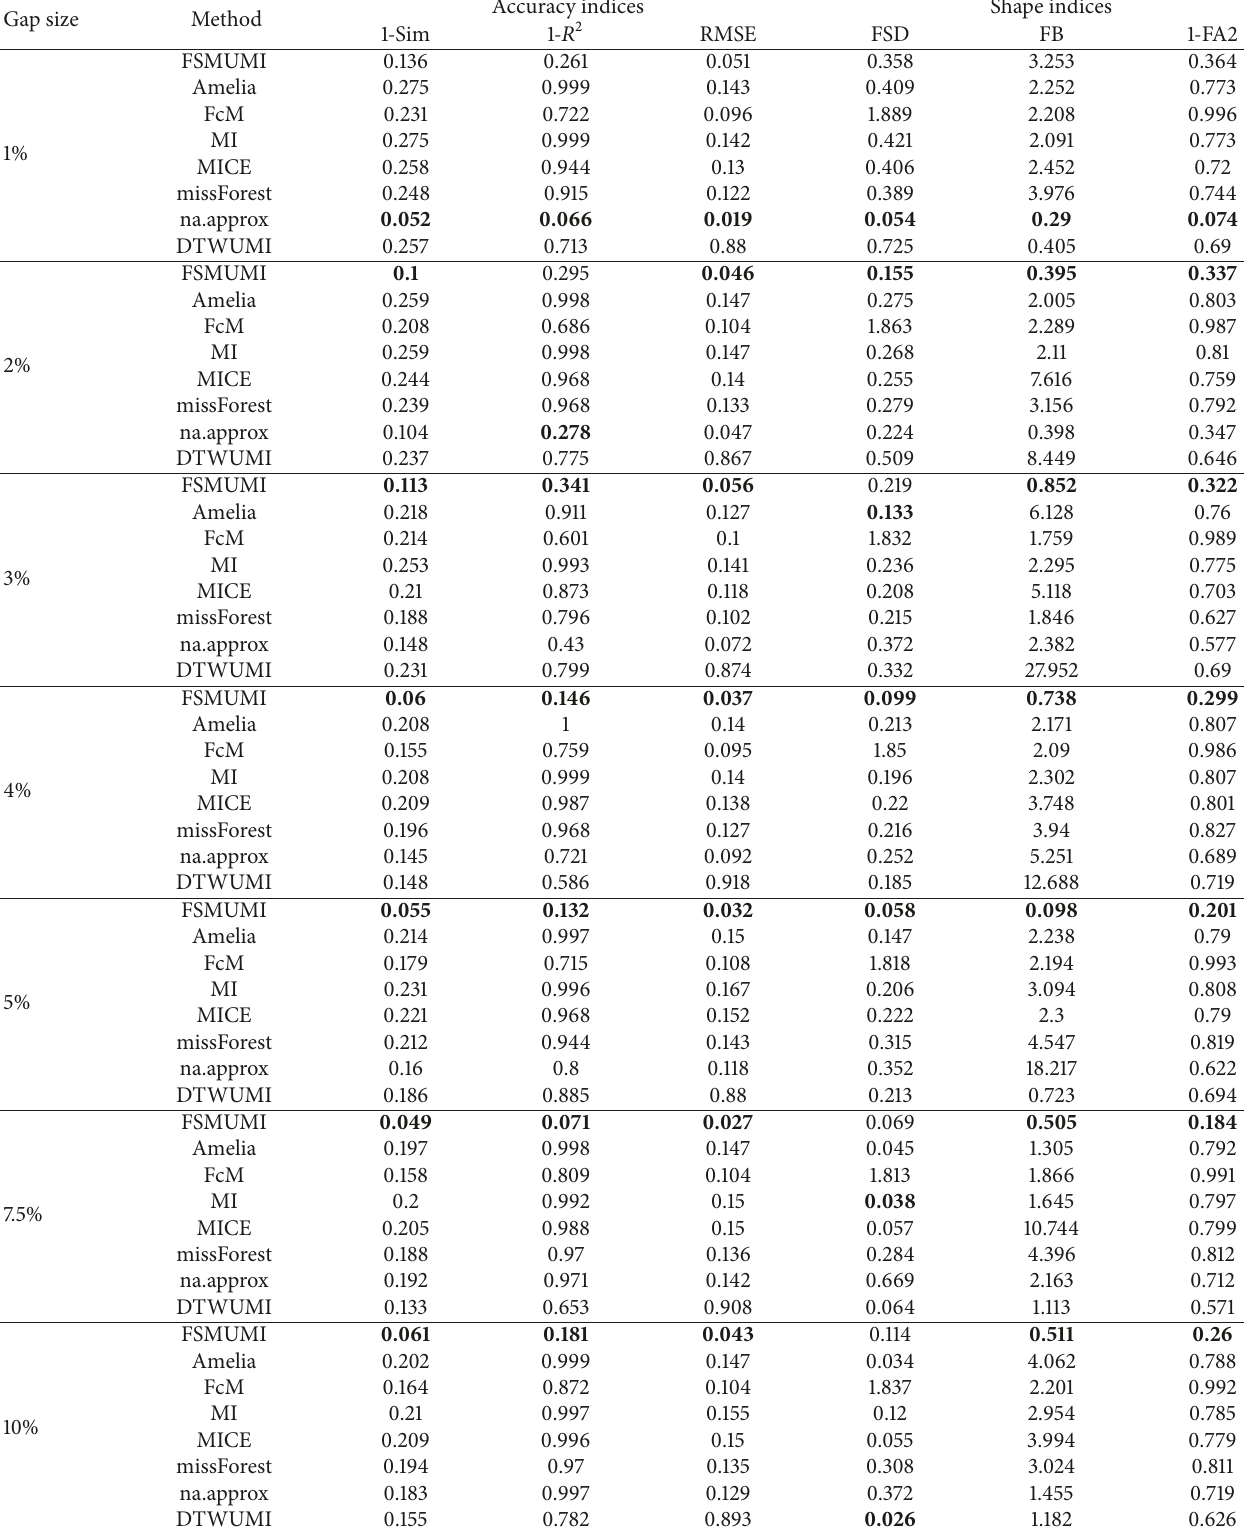
Table 1: Average imputation performance indices of various imputation algorithms on synthetic dataset (100,000 collected